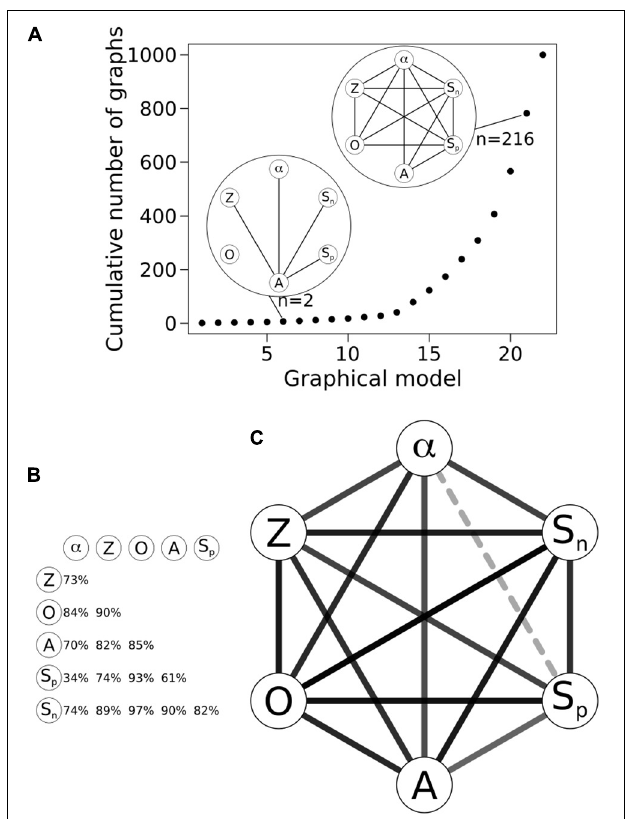
FIGURE 6 | Graphical model that identifies which nodes (circles representing parameters) are linked by edges (lines). Descriptions of each parameter can be found in Table 1 . (A) A plot of the cumulative number of graphical structures and number of graphical models estimated using the bootstrap approach. In total twenty-two networks are estimated, with two of the networks identified (n is equal to the number of times that network is identified as best-fitting the data). Given that learning under bootstrap identifies 22 networks, it’s a sign that the learning process is robust against noise; (B) The percentage of the 1000 bootstrapped networks that contain the respective edge. By performing this bootstrap 1000 times we reduce the effects of noise on our analysis, and improve the strength of the probabilistic correlations. Running the bootstrap analysis multiple times will result in some variability in the strength of the probabilistic relationships ( ± 2%). However, the relative strengths of the edges, is what we are most interested in, and these remain, even if the absolute values of the probabilistic relationships varies slightly; (C) The resulting graphical model from the bootstrapped networks. The darkness of the edge represents the number of times that edge appears in the bootstrapped graphs. Edges that do not pass a significance threshold are labeled with a dashed line. FIGURE 7 | The distribution of the power-law slope parameter (